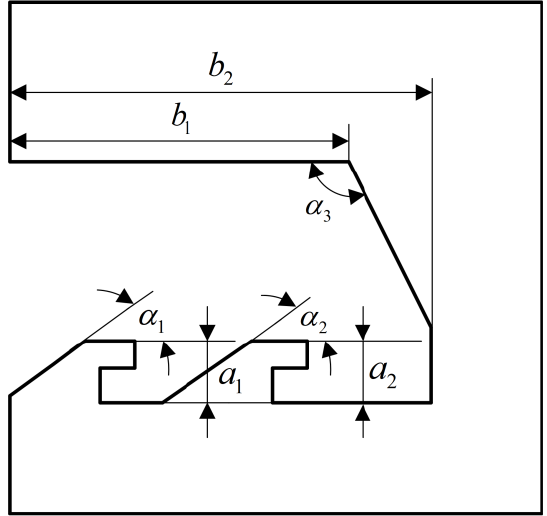
Figure 15. Characteristic dimensions. Table 2. Design values of characteristic dimensions.